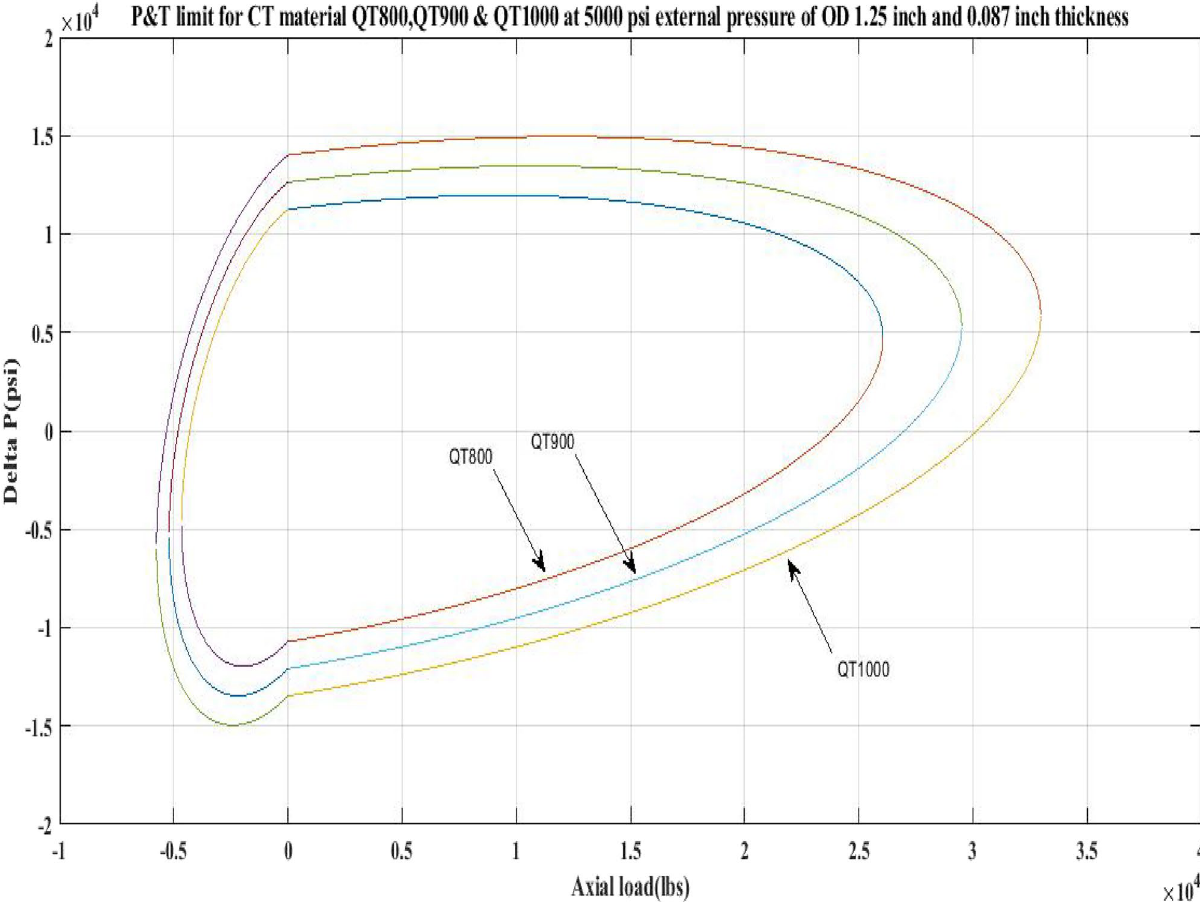
Figure 6. Pressure and tension limits for QT 800, QT900 and QT 1000 at 5000 psi external